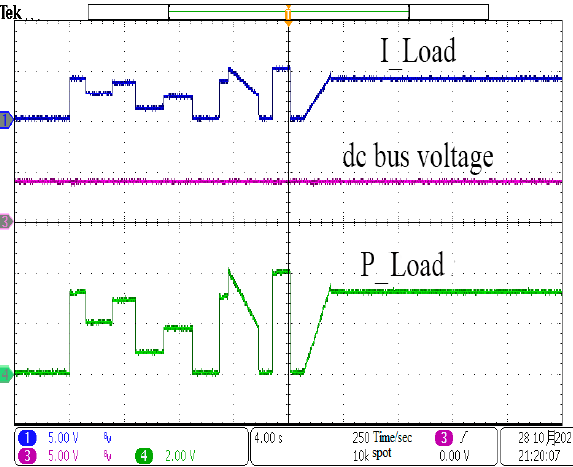
Figure 18. Current, power load, and the DC-link voltage output current, voltage, and power under load and radiation changes; ( 月 is month).